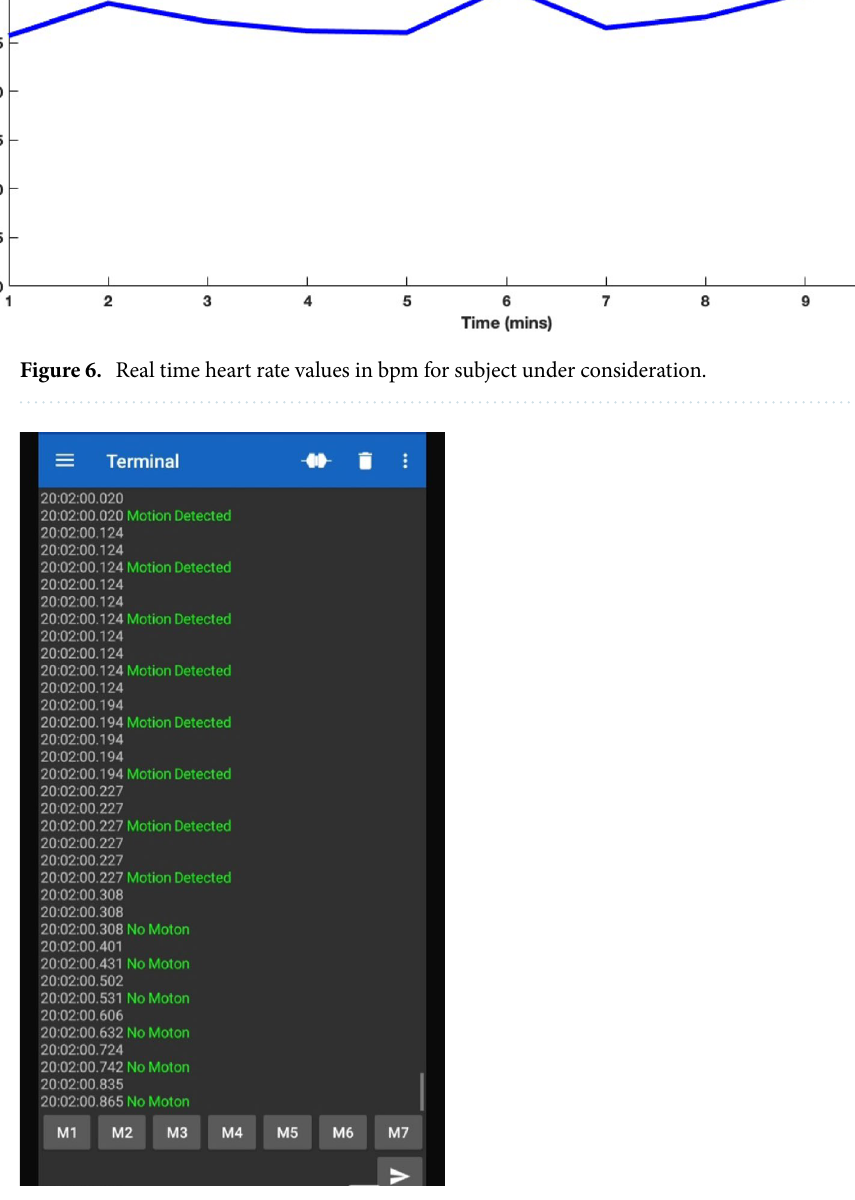
Figure 7. Motion Detection using ADXL 362 being visualized on a Bluetooth